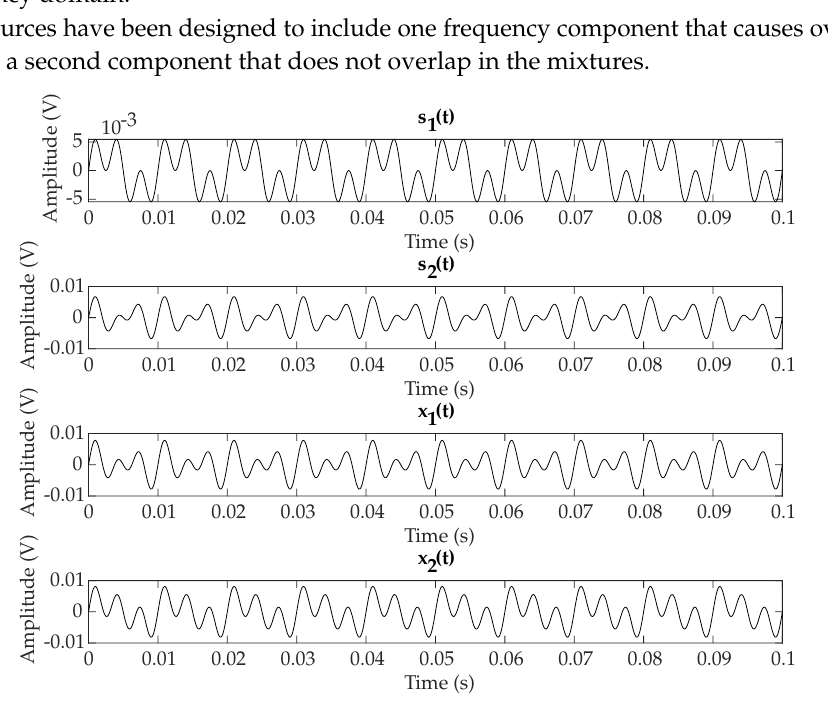
Figure 1. Rows 1 and 2 illustrate two sources signals. Source 1, s 1 ( t ) , has a 100 Hz and a 300 Hz frequency component. Source 2, s 1 ( t ) , has a 200 Hz and a 300 Hz frequency component. Rows 3 and 4 illustrate pan-mixed mixtures of the sources, x 1 ( t ) and x 2 ( t )